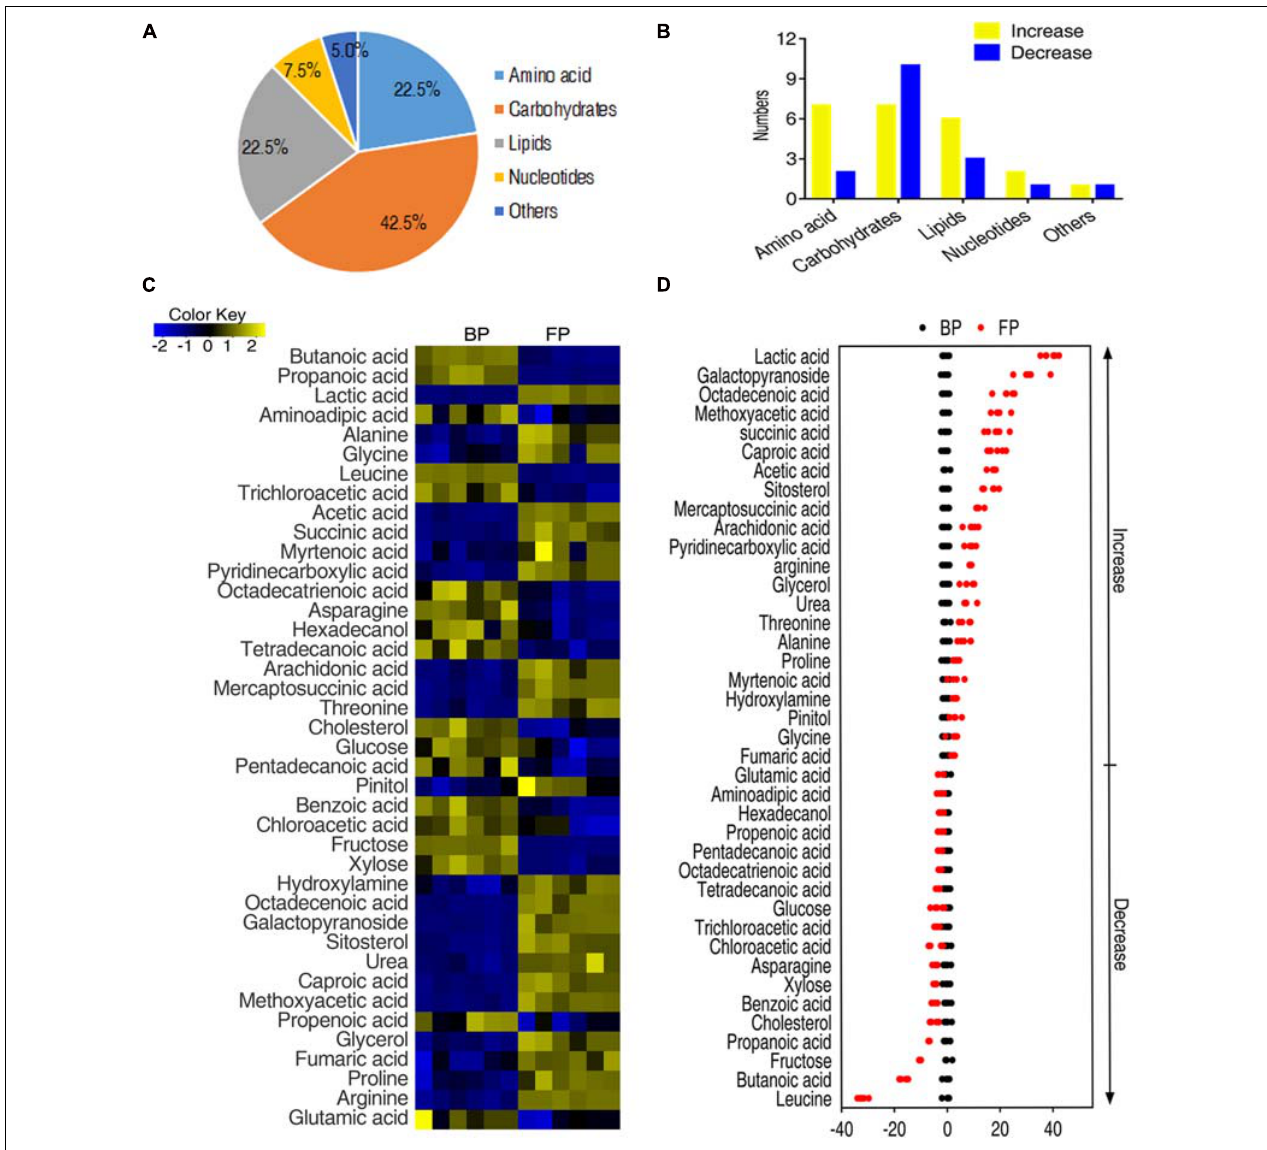
FIGURE 2 | Metabolic profiling of monocytes/macrophages of O. niloticus before and after phagocytosis. (A) Functional categories of the differential metabolites. (B) Histogram of altered metabolite of each functional category after phagocytosis. (C) Changes of differential metabolites in tilapia head kidney monocytes/macrophages following phagocytosis of bacteria by Wilcoxon, p < 0.01). (D) Z-score plots of differential metabolites of tilapias head kidney monocytes/macrophages following phagocytosis of